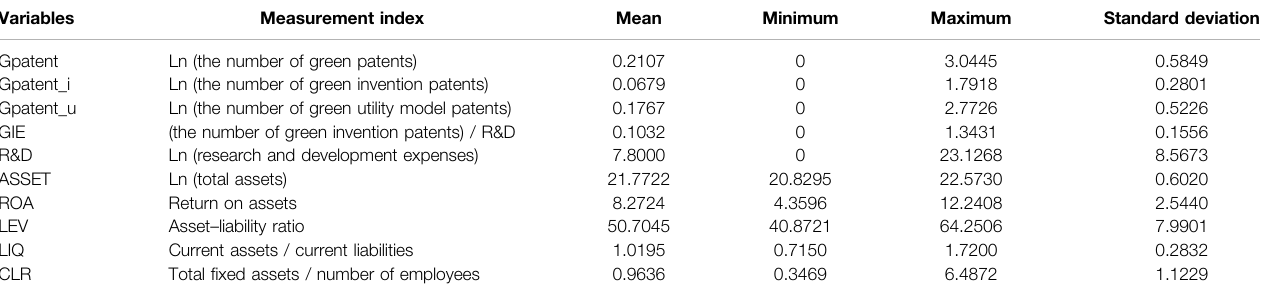
TABLE 1 | Summary of descriptive statistics.